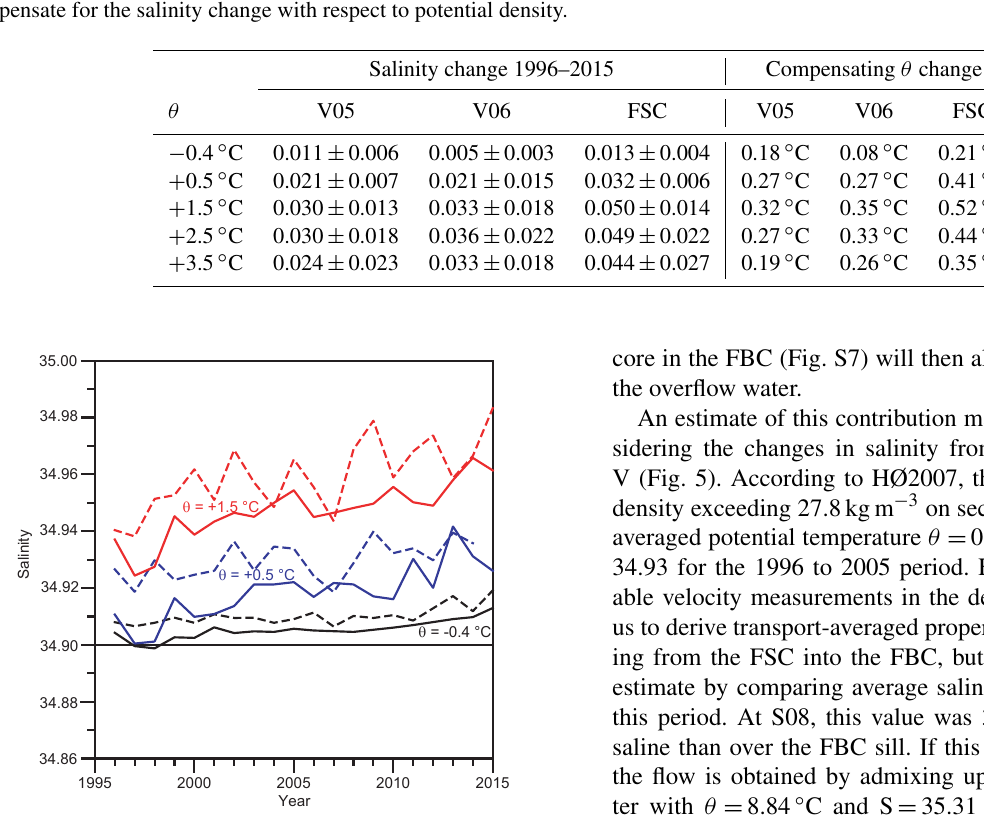
Table 2. Salinity increase at five fixed potential temperatures ( θ) from 1996 to 2015 based on linear trend analyses for two stations on section V and stations in area A in the FSC (Fig. 1). The last three columns show the change in potential temperature that would be required to compensate for the salinity change with respect to potential density.